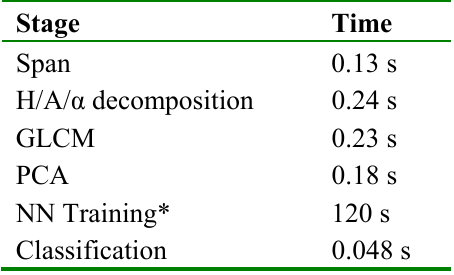
Table 10. Computation Time of Flevoland image